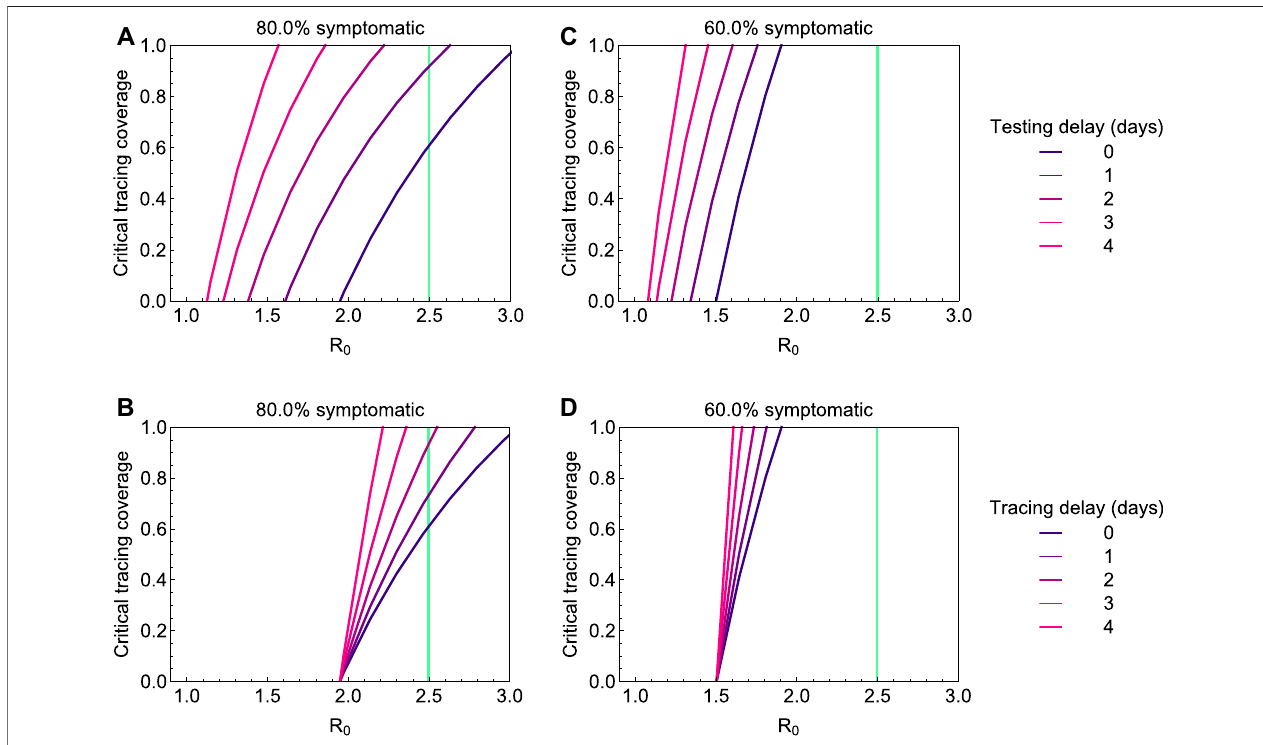
FIGURE 4 | The critical tracing coverage for varying values of the basic reproduction number R 0 ; (A) 80% symptomatic and diagnosed index cases and varying testing delay, (B) 80% symptomatic and diagnosed index cases and varying tracing delay for both household and non-household contacts; (C) 60% symptomatic and diagnosed index cases and varying testing delay, (D) 60% symptomatic and diagnosed index cases and varying tracing delay for both household and non-household